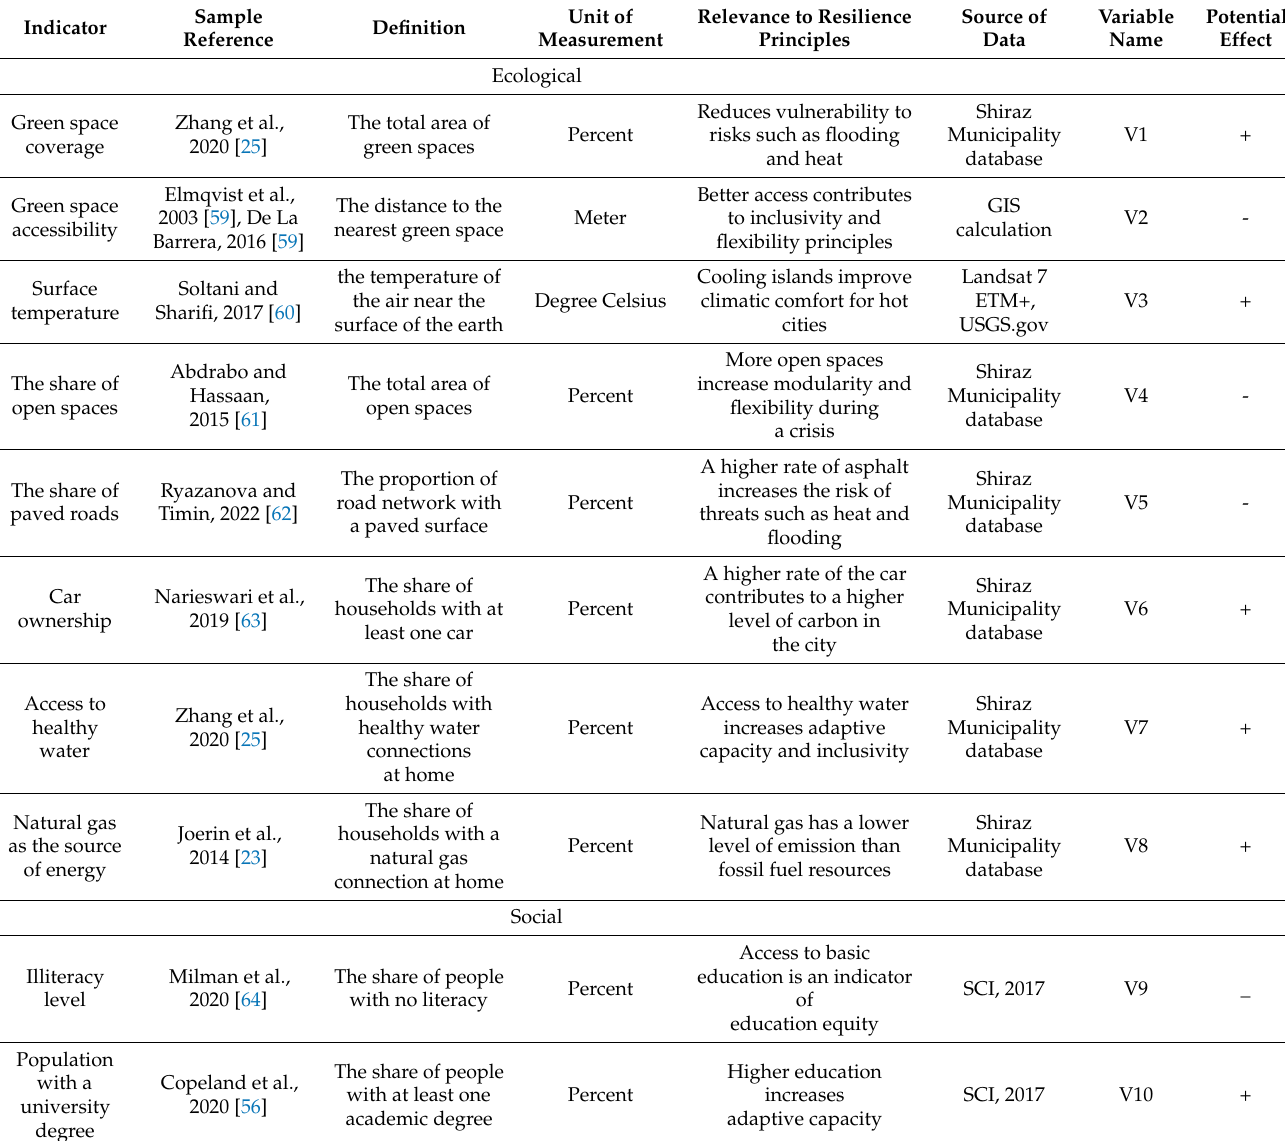
Table 1. Urban resilience indicators and their